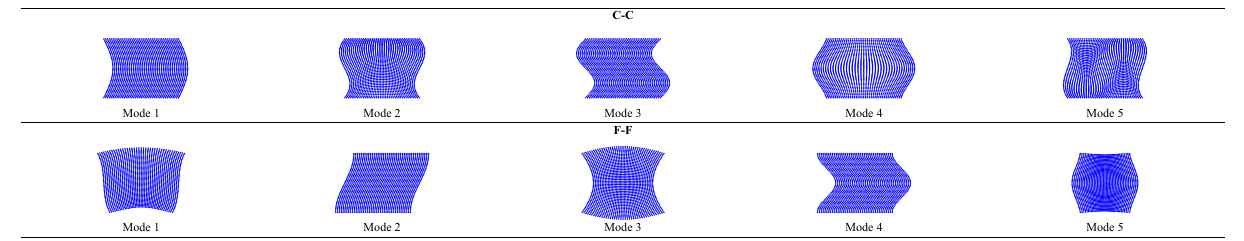
Figure 6. The first five vibration modes of isotropic plates with two opposite SS1 edges at x = 0 and x = a